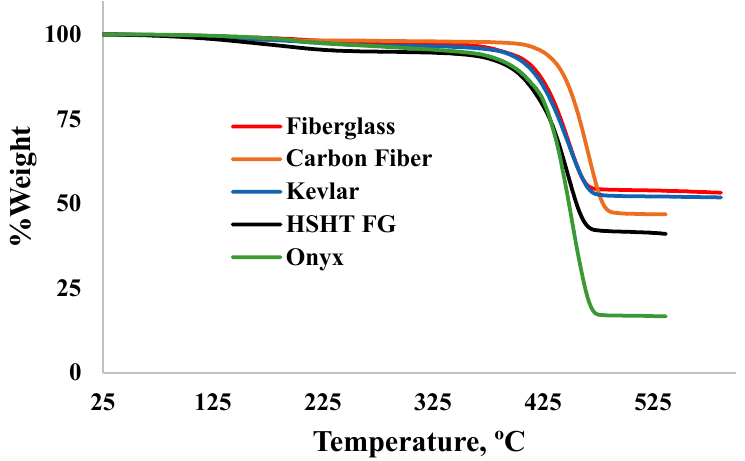
Figure 2. Thermo-gravimetric analysis (TGA) spectra of composite filaments.